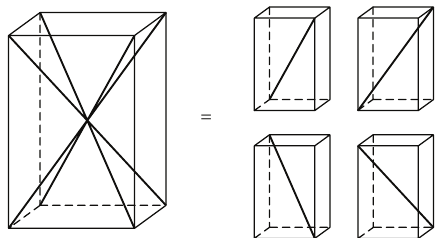
Figure 2: Internal cell and fiber (thick solid line)